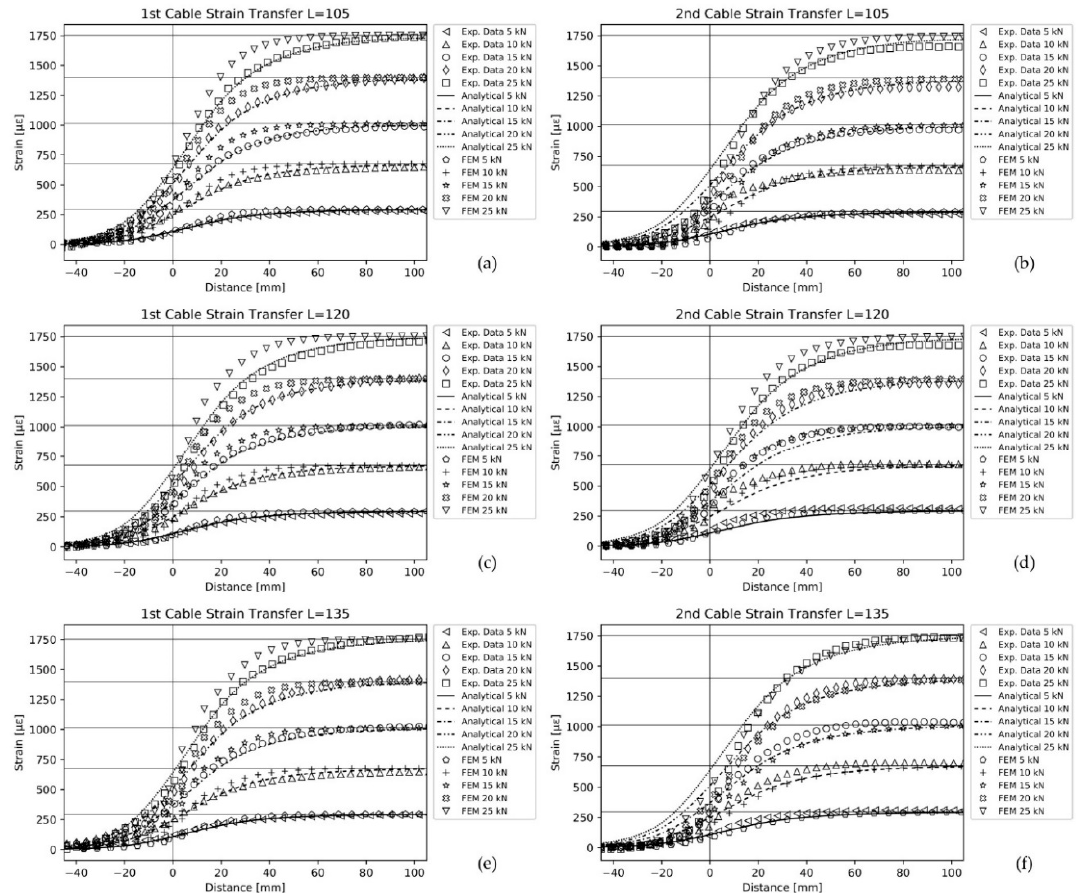
Figure 8. Comparison between experimental data, numerical results and analytical model.